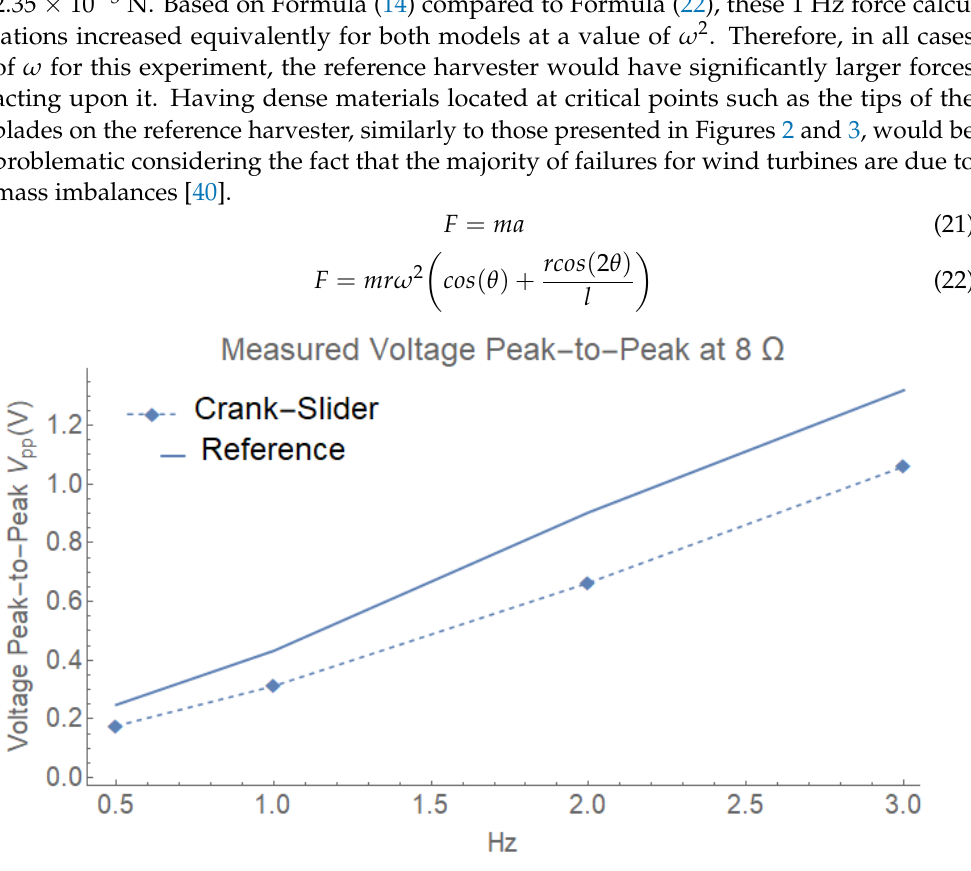
Figure 15. Measured peak-to-peak voltage demonstrating that the reference harvester had higher values than the crank-slider harvester at 0.5, 1, 2, and 3 Hz with a 8.4 Ω load, signifying that the crank-slider harvester would have a greater range of wire gauge